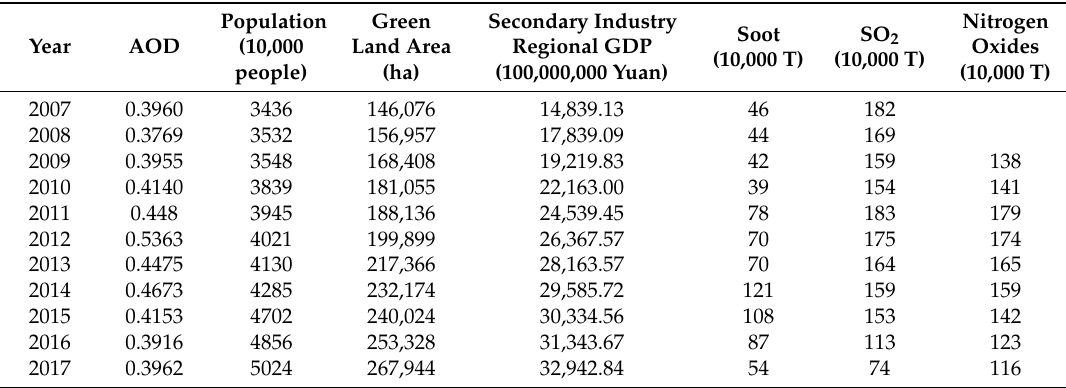
Table 1. AOD and socio-economic impact factors.